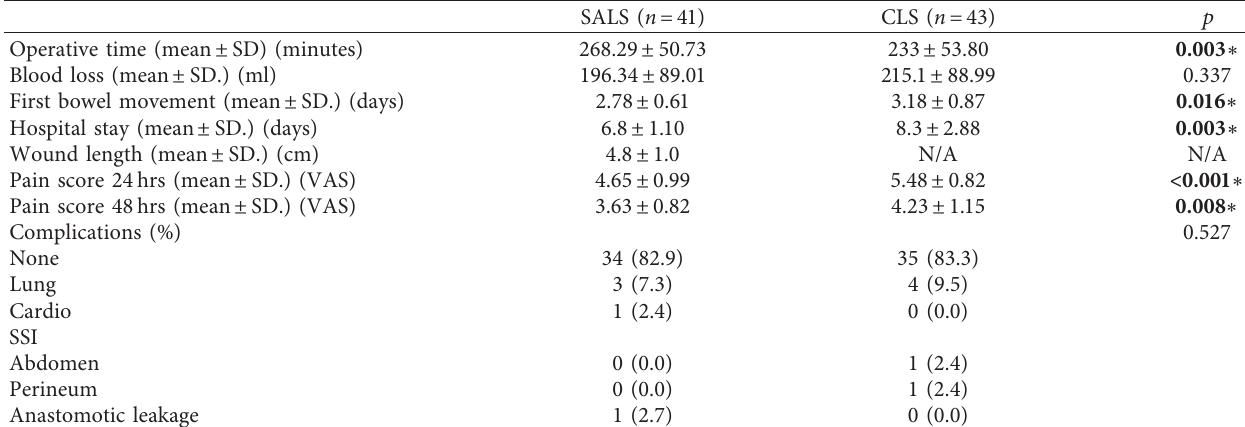
Table 2: Intraoperative and postoperative